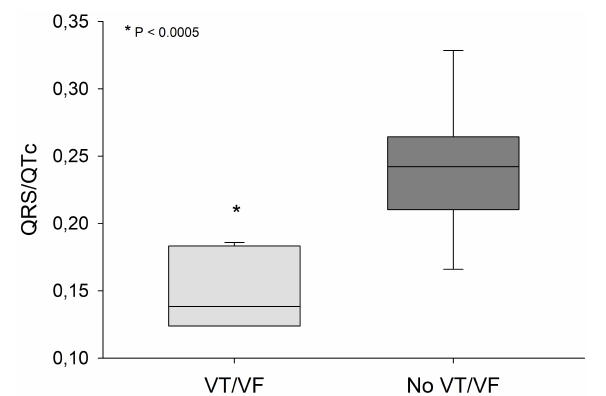
FIGURE 2 | QTc values were significantly lower ( p < 0.05) in patients that developed VT/VF after first ECG-recording compared to patients that remained in sinus rhythm. Solid line: Median, box-plot: 25- to 75-persentile, and error bars: 5- and 95-persentile. *Difference from «No VT/VF group» ( p < 0.05). VF, ventricular fibrillation; VT, ventricular